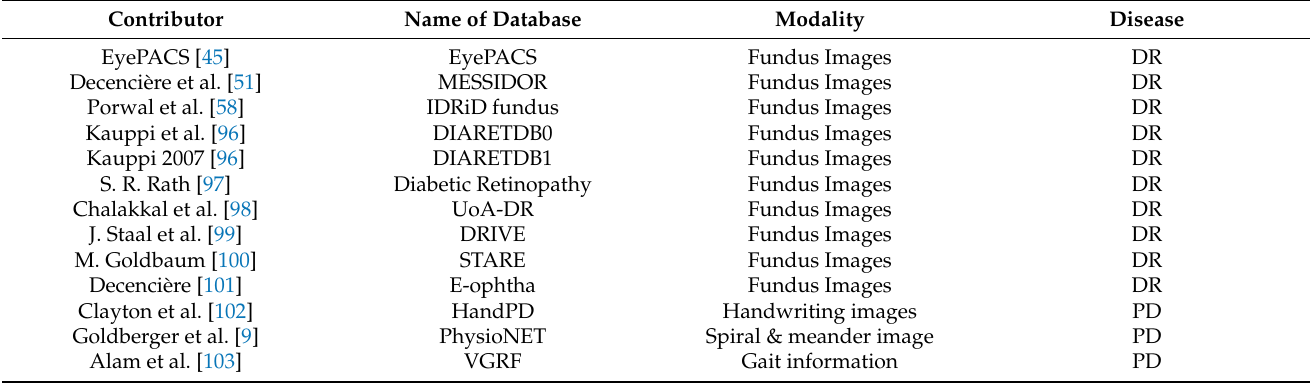
Table 3. Public datasets available for conducting disease severity identification